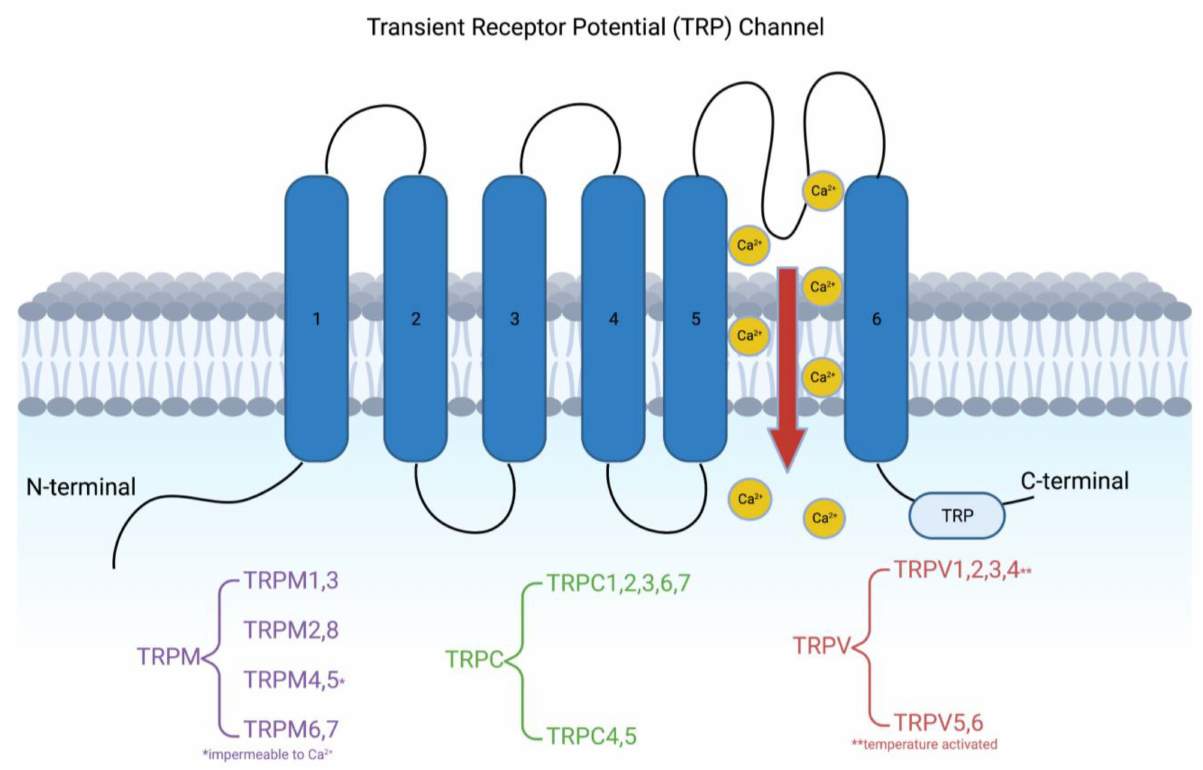
Figure 1. Visualization of the generic structure of the transient receptor potential (TRP) channel, consistent for most families within the class. The pore between the fifth and sixth transmembrane domains yields nonselective calcium ion permeability. TRPM4 and TRPM5 are two exceptions, as they are calcium impermeable channels (Created with